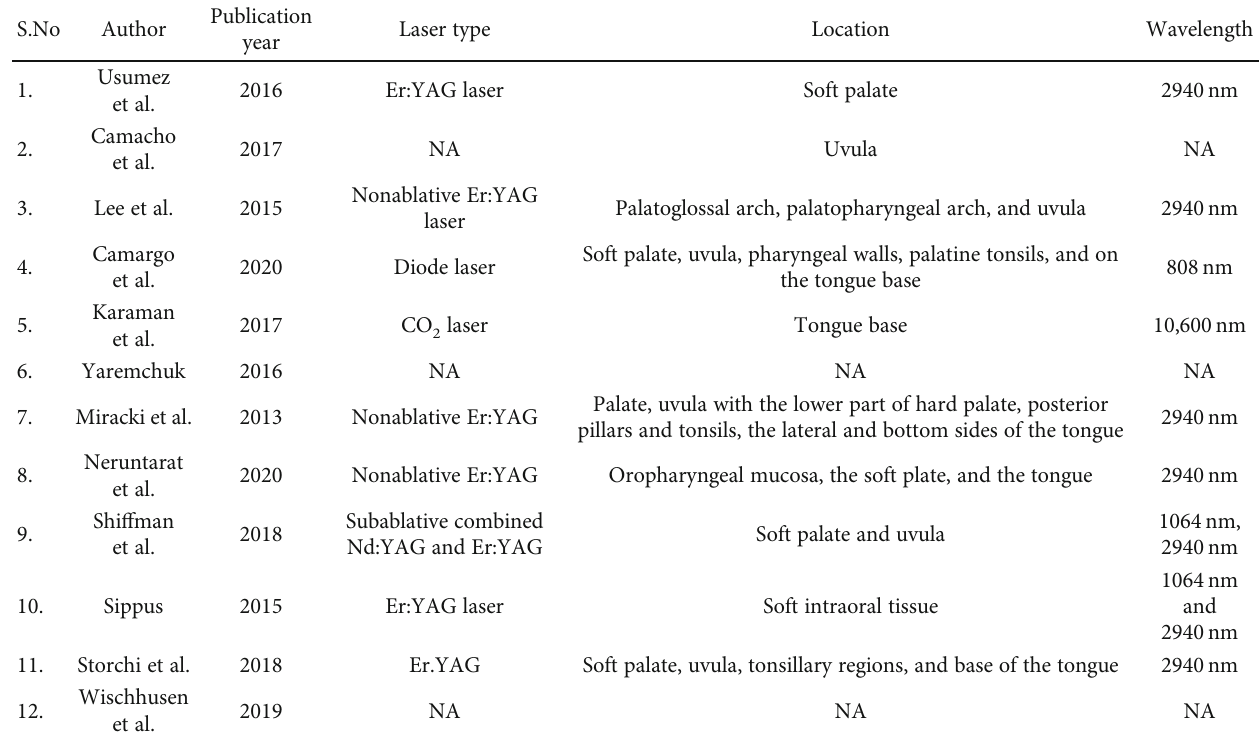
Table 5: Type of laser, location, and